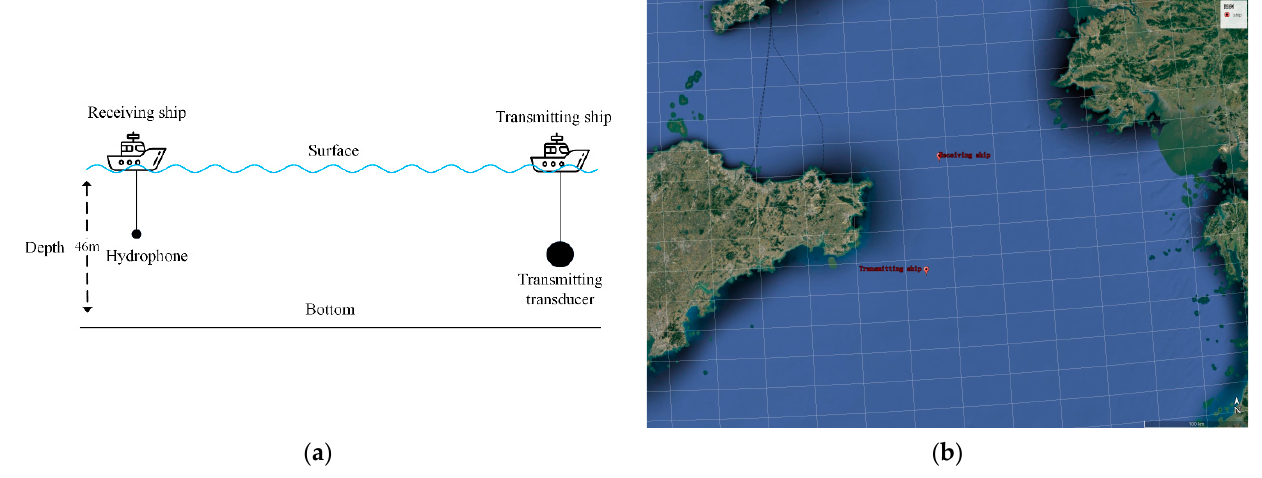
Figure 6. Schematic diagram of the sea experiments: ( a ) layout diagram; ( b ) satellite image.